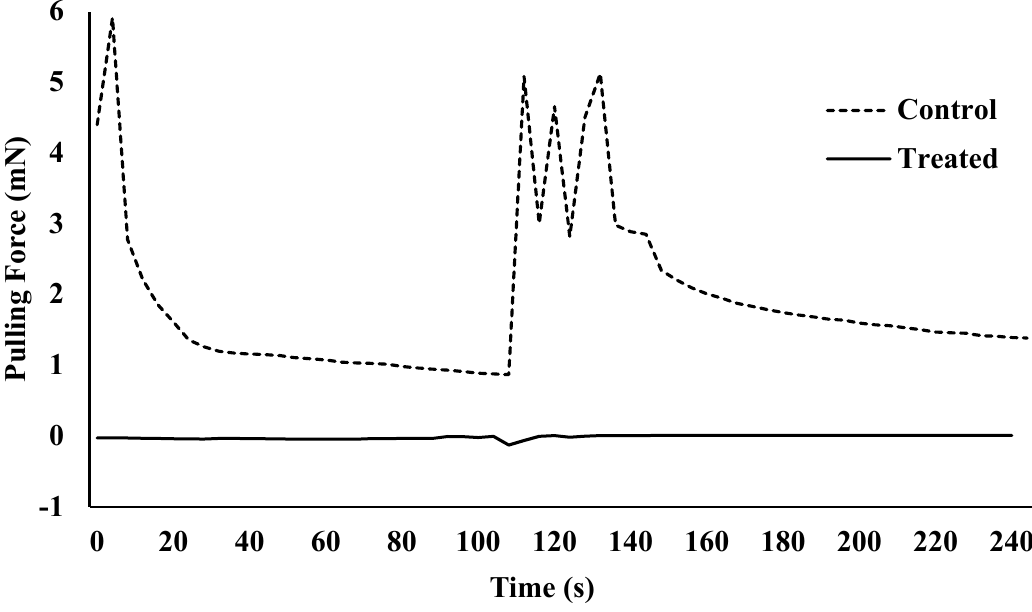
Figure 4. Pulling force over time for one Harlan strain bed bug that was non-treated (control) or treated with lufenuron (0.0016% w / v ).